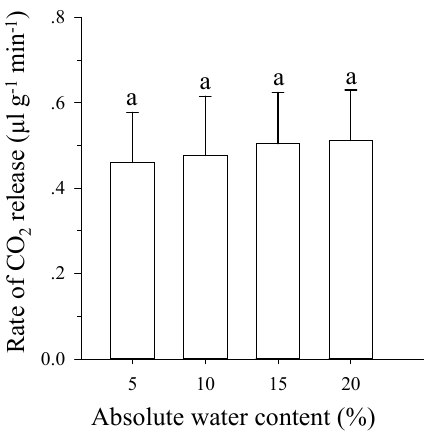
Figure 5. E ff ects of soil moisture on pupae respiration rates. Means ( ± SE) among di ff erent levels soil Figure 5. Effects of soil moisture on pupae respiration rates. Means (±SE) among different levels soil moisture followed by di ff erent letters di ff er at p < 0.05 (Tukey HSD moisture followed by different letters differ at p < 0.05 (Tukey HSD test).